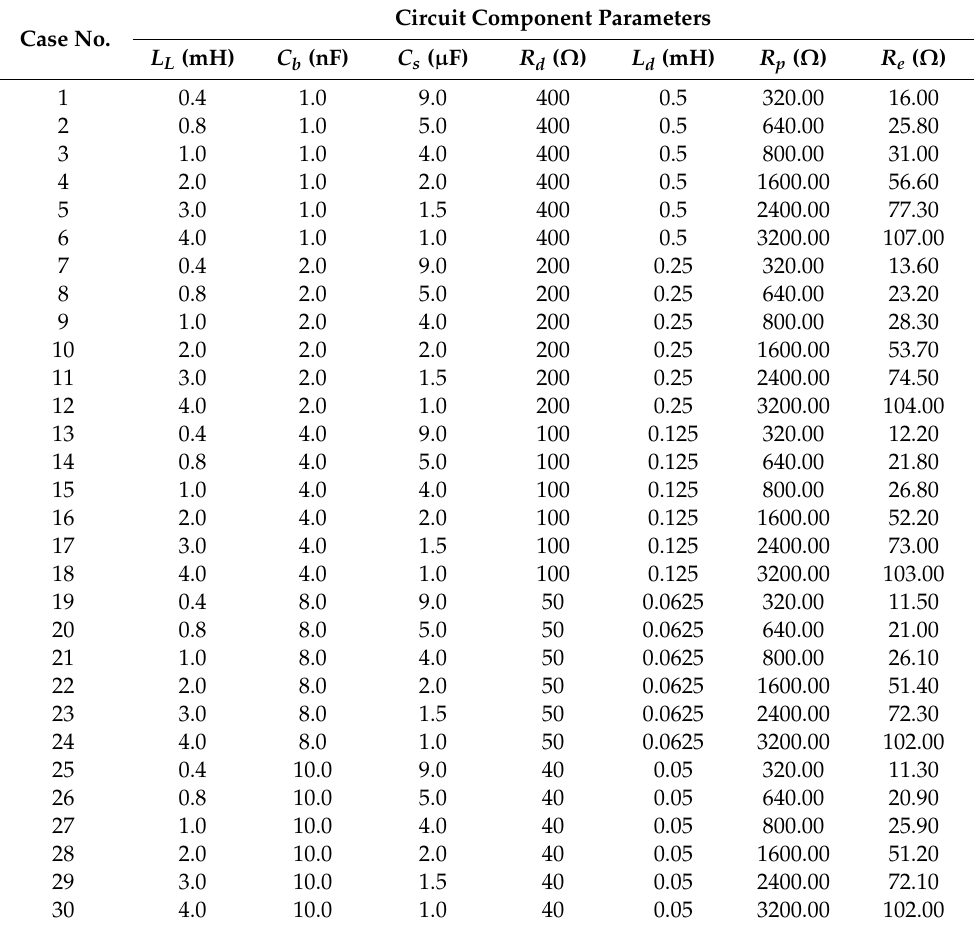
Table 3. Circuit component parameters calculated by Feser’s approach. Case No.